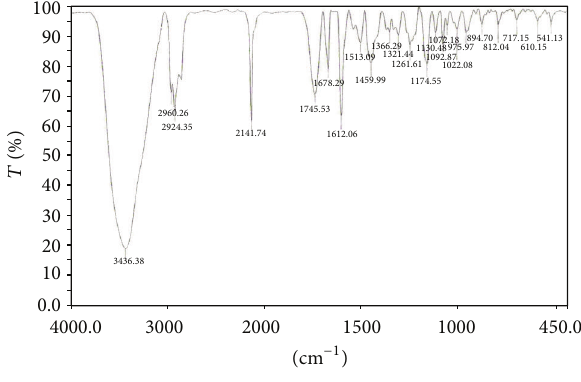
Figure 1: FTIR spectra of WAS.